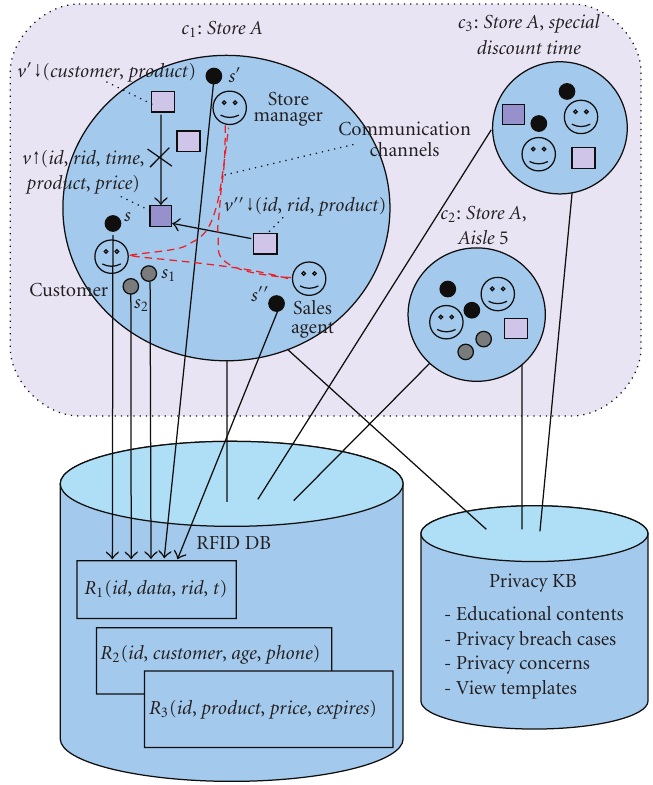
Figure 4: Applying our framework to a retail RFID